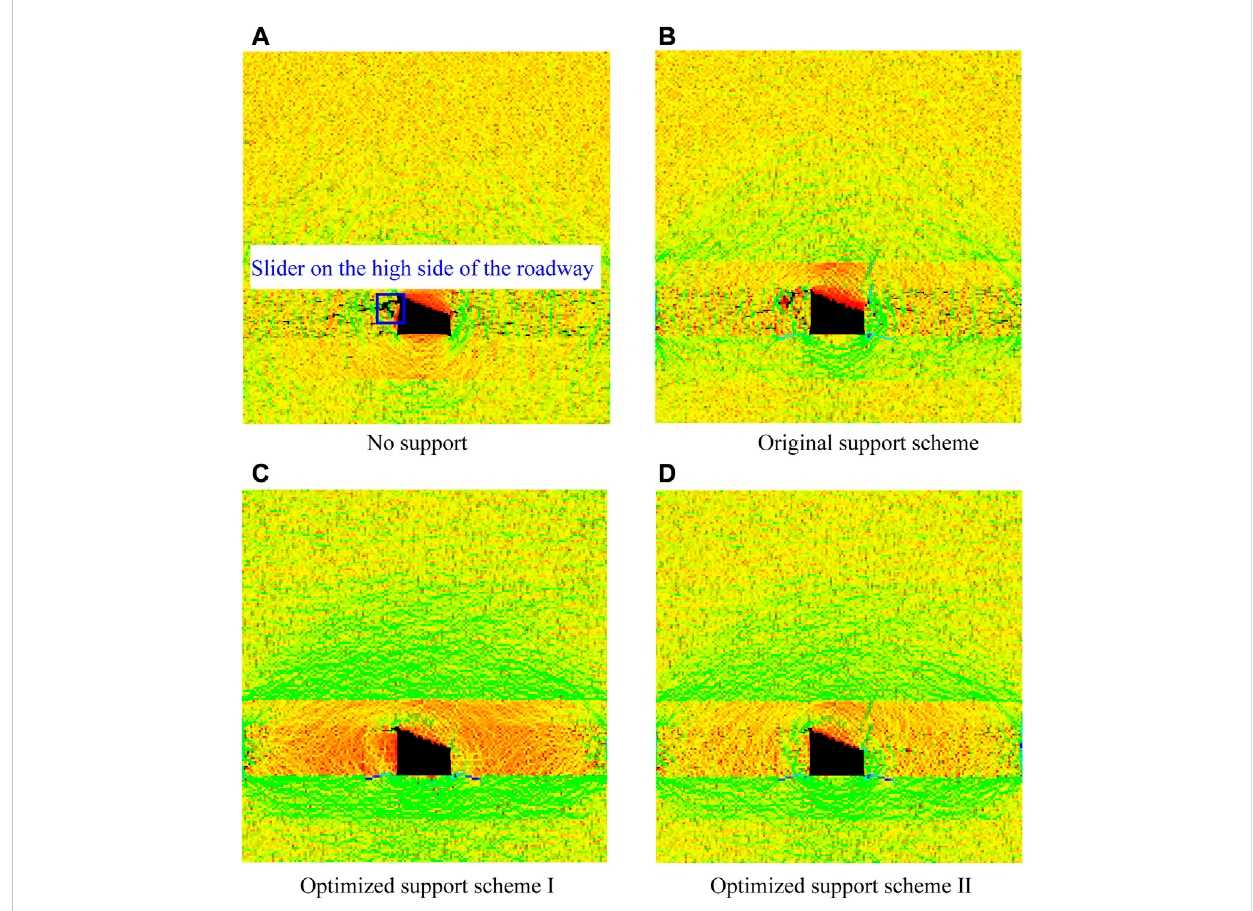
FIGURE 11 Deformation and failure mode of the surrounding rock under various support schemes. (A) No support. (B) Original support scheme. (C) Optimized Support Scheme I. (D) Optimized Support Scheme II.